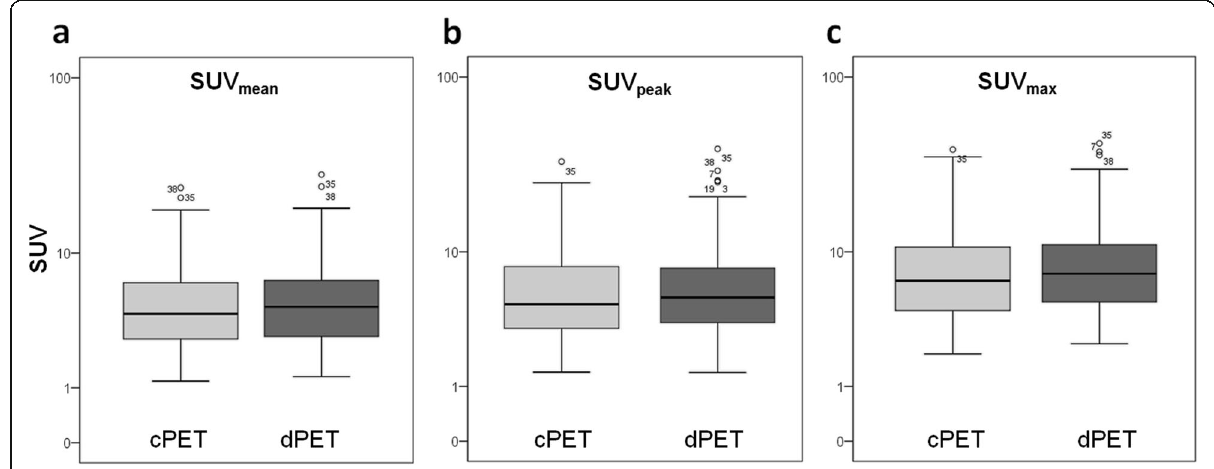
Fig. 1 SUV mean ( a ), SUV peak ( b ) and SUV max ( c ) as measured on cPET and dPET across all lesions ( n = 128). The y -axis is shown on a log scale. Average dPET values were significantly higher than cPET values for all three parameters ( p < 0.001). This boxplot shows the median, interquartile range and outliers (o): values that are between 1.5 and 3.0 box length from the percentile borders